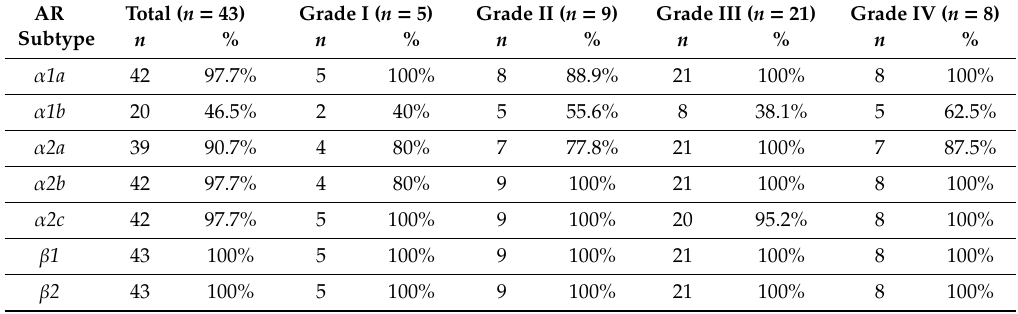
Table 1. AR gene expression distribution in human IVD tissues with different degrees of degeneration ( n = 43). AR